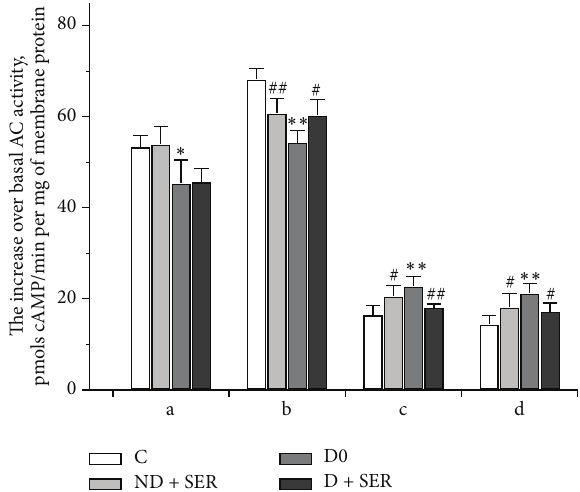
Figure 7: The AC stimulating effects of agonists of adrenergic receptors in the myocardium of diabetic and nondiabetic rats and the influence of IS treatment. a—norepinephrine, b—isoproterenol, c—BRL-37344, and d—CL-316243 (all were used at a concentration of 10 −5 M). The AC stimulating effect was expressed as hormone- induced increase of AC activity over the basal enzyme activity, pmol cAMP/min per mg of membrane protein. The data are presented as M ± SD. ( ∗ , ∗∗ ) The difference between Groups C0 and D0 and (#, ##) the difference between Groups C0 and ND + SER or between Groups D0 and D + SER are significant at 𝑃 < 0 . 05 and 𝑃 < 0 . 0001,